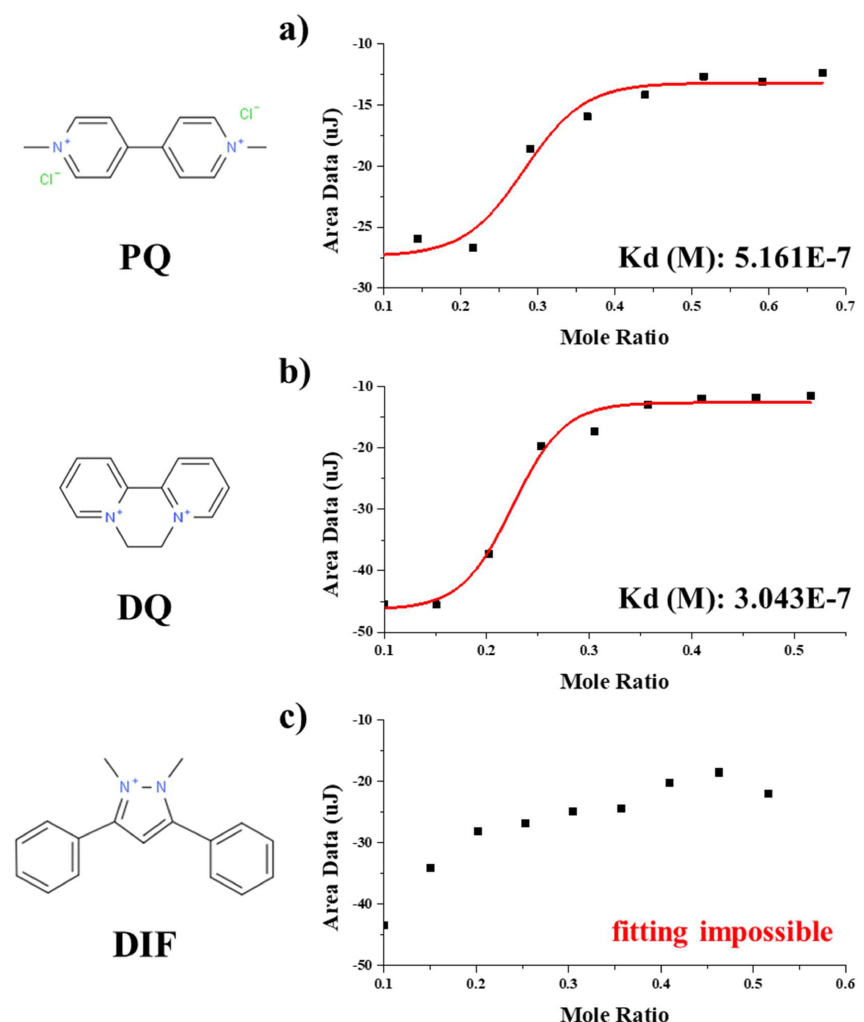
Figure 1. BindingisothermofthePQ-bindingphageto( a )paraquat(PQ),( b )diquat(DQ),and( c )difenzoquat (DIF) measured by ITC. Red line is the result of fitting using the one-site binding model. In the DIF result, fitting is impossible because the raw ITC data is not stable (Figure S6 in Supplementary